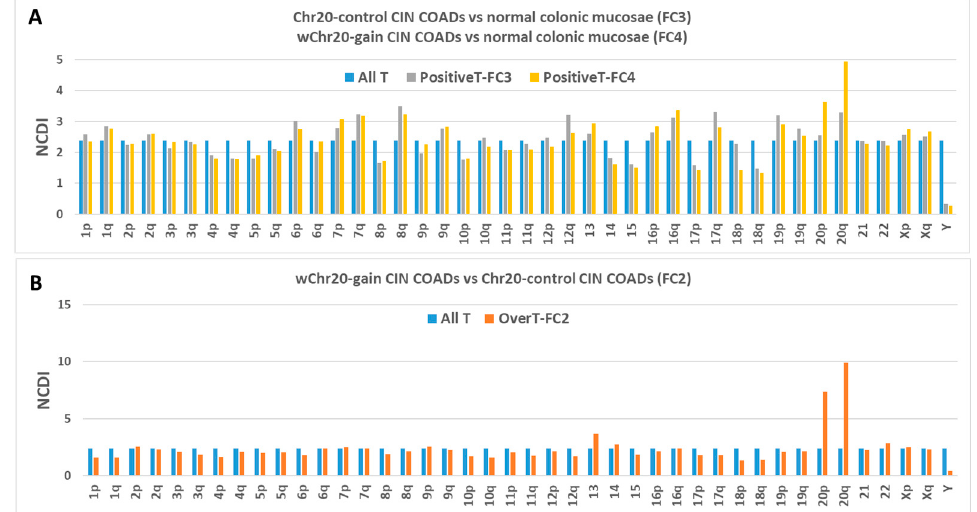
Figure 4. Percentage chromosomal distribution (expressed as NCDI) of different transcript classes in Chr20 control and wChr20-gain CIN-positive colon cancer groups: ( A ) All transcripts (All T), PositiveT-FC3, and PositiveT-FC4); ( B ) All T and OverT-FC2.